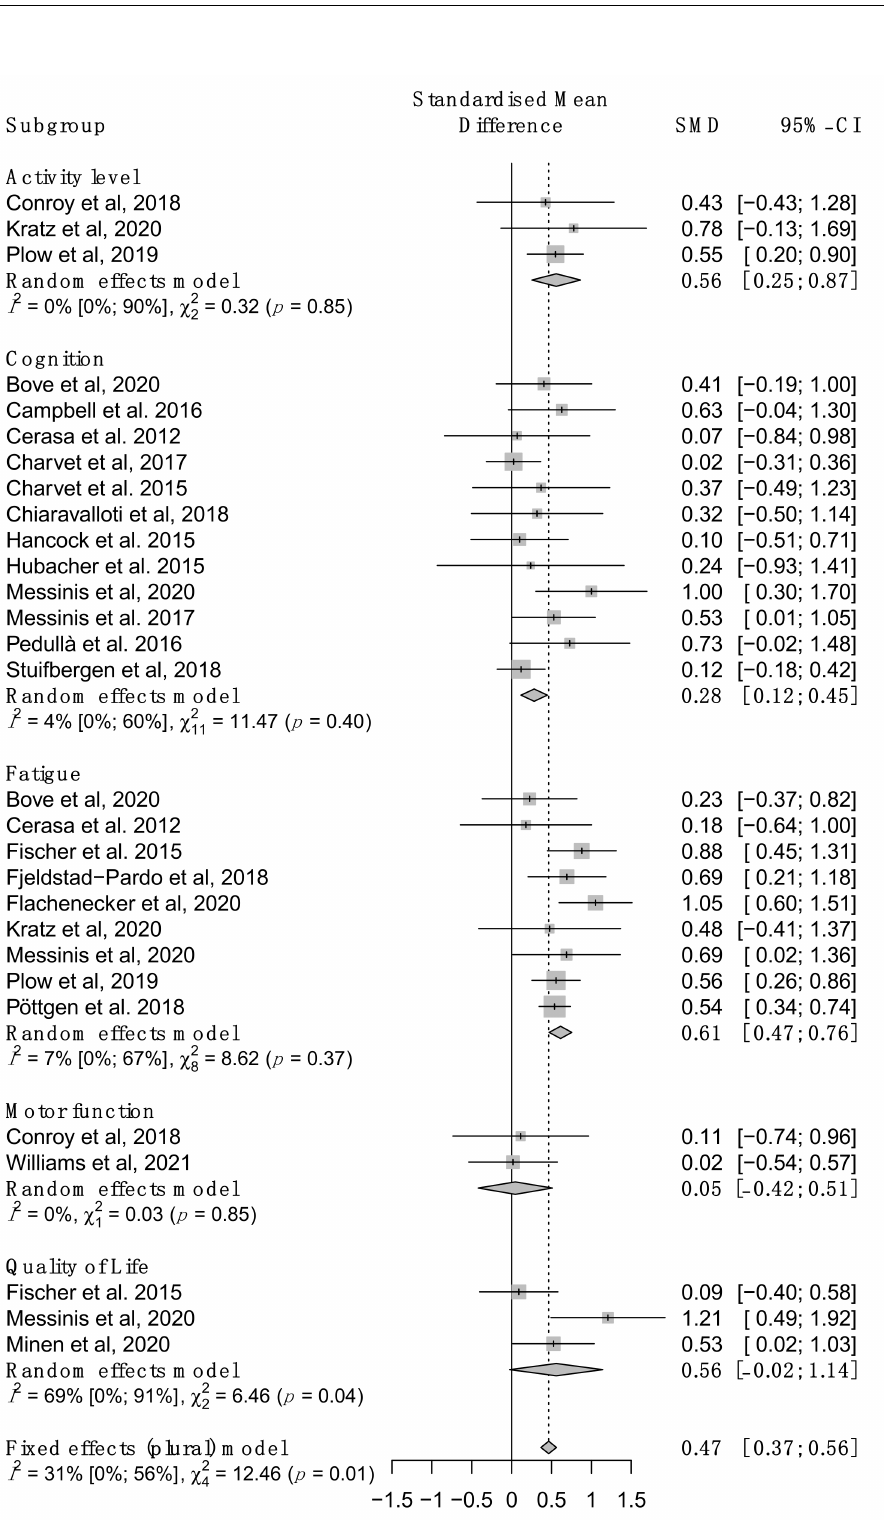
Figure 3. Stratified meta-analysis according to ICF domains, results are indicated with 95% confidence intervals Positive Standardized Mean Differences (SMD) indicates superior efficacy of the mHealth intervention compared to control group [24,26–31,33–37,39,40,44,45,47–49,51,65]. At the ICF domains level, we observed the biggest effect for fatigue (SMD = 0.61 [0.47; 0.76]), followed by outcome measures at the activity level (SMD = 0.56 [0.25; 0.87]) and cognitive impairment (SMD = 0.28 [0.12; 0.45]). Note that for activity level these results must be interpreted carefully due to the small number of included studies ( n = 3).